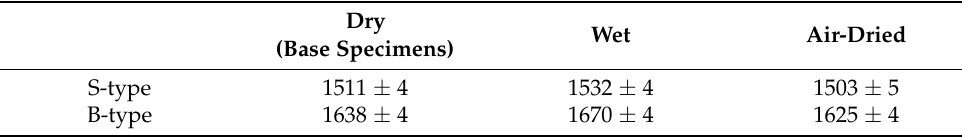
Table 2. Total mass per unit area (g/m 2